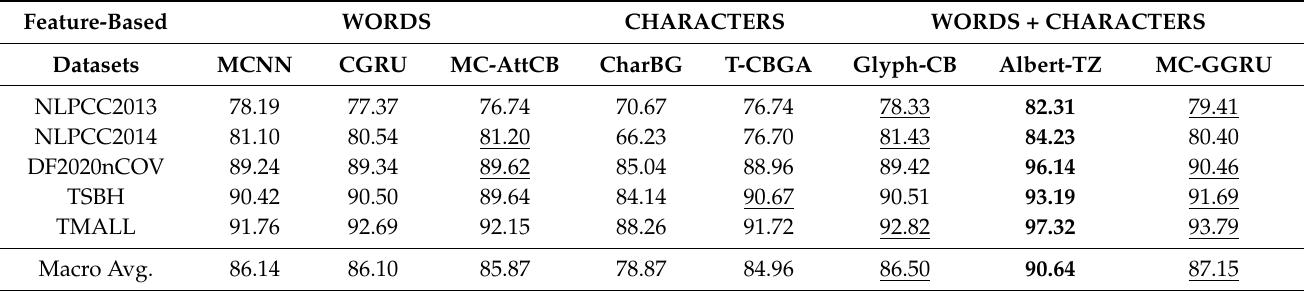
Table 2. The accuracy (%) on the test set for the Chinese corpus sentiment task. The models are divided into four categories: words-based, characters-based, and words- and characters-based. The bolded ones are the SOTA performance using the pre-trained model Albert, and the underlined ones are the best two performances for the non-pre-trained